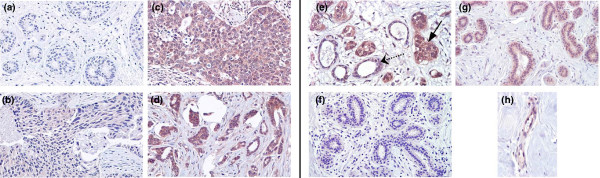
Phosphorylated Akt expression in tumour and normal tissues of the breast. (a-d) Phosphorylated Akt (P-Akt) staining of invasive ductal carcinomas (IDCs) of the breast ranging from undetectable to intense staining. The scoring system was from 0 to 3 and examples of such are represented in panels a-d, respectively. (e) Normal ducts (dashed arrow) adjacent to the IDC (solid arrow) expressed appreciably less P-Akt. (f) Likewise, P-Akt staining was weak when whole sections of normal breast tissue were stained. (g) However, some cases of normal breast tissues stained more intensely for P-Akt. (h) It was also noted that P-Akt was present in endothelial cells surrounding the tumours. Original magnifications: panels a-g, 200×; panel h, 400×.